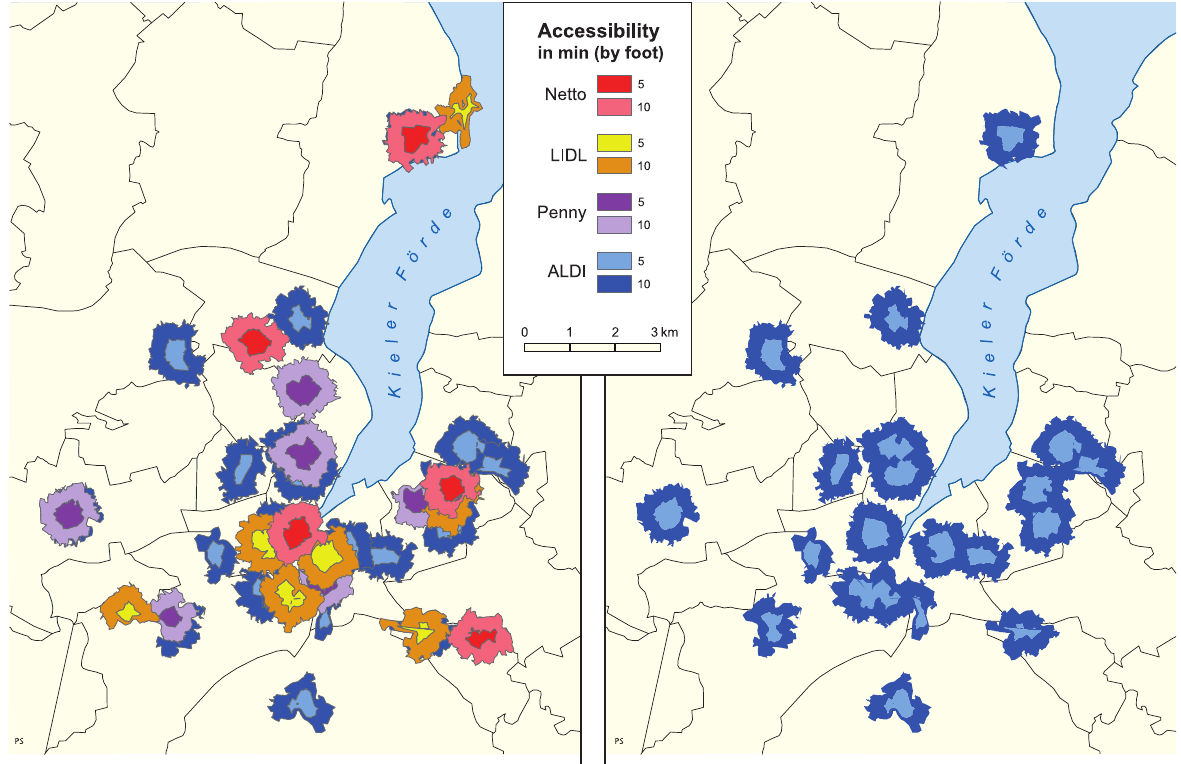
Fig. 3. Accessibility of discounters by foot in the city of Kiel, Germany. Source: Nielsen Company 2011, content prepared by S. Schnitker (GIS), cartographic elaboration by P.